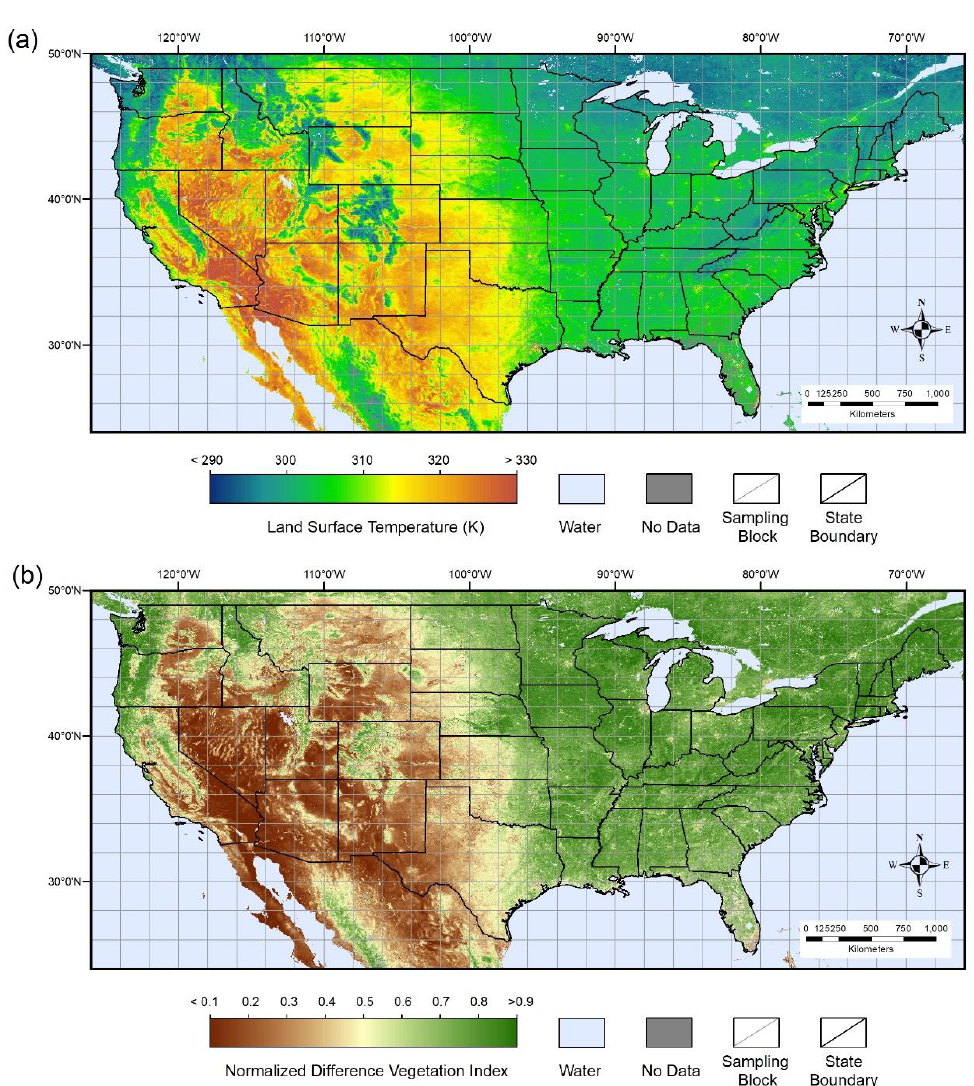
Figure 1. Map of the study area showing the 2° × 2° (approximately 200 km) sampling blocks and examples of the 10-year (2008–2017) average land surface temperature (LST) and normalized difference vegetation index (NDVI) images for 12–19 July. ( a ) LST. ( b ) NDVI. Data source: Moderate Resolution Imaging Spectroradiometer (MODIS) Collection 6 MYD11A2 and MYD09A1 (Table 1).